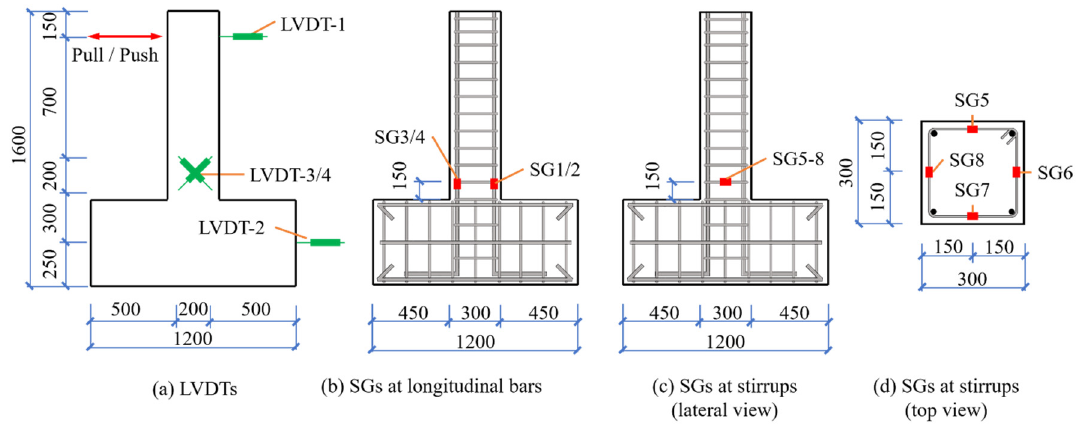
Figure 5. Layout of measuring points (unit: mm).